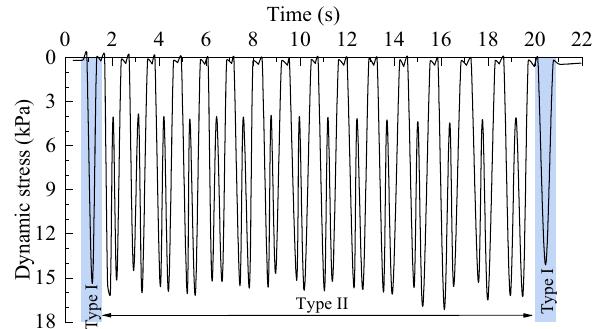
Fig. 1 Typical time history of measured dynamic stress over road- bed of ballastless tracks [16]: two types of characteristic shapes are explained in Fig. 2